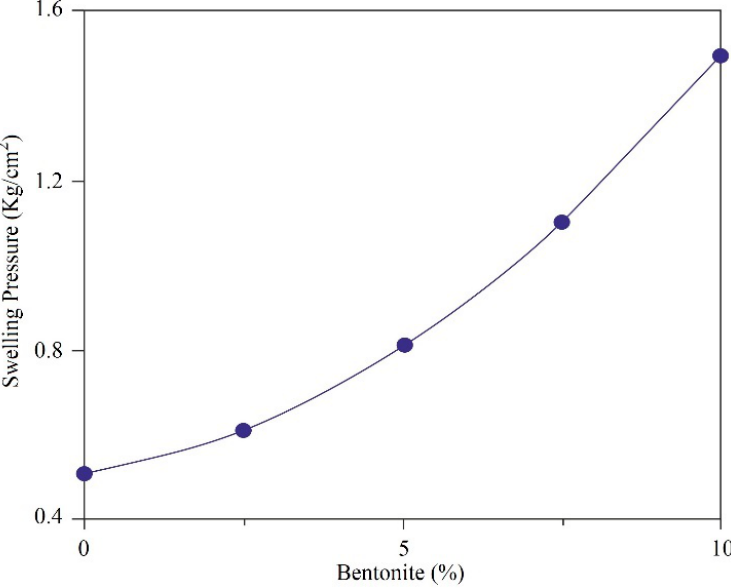
Figure 7. Effect of the Bentonite percentage on the swelling pressure.